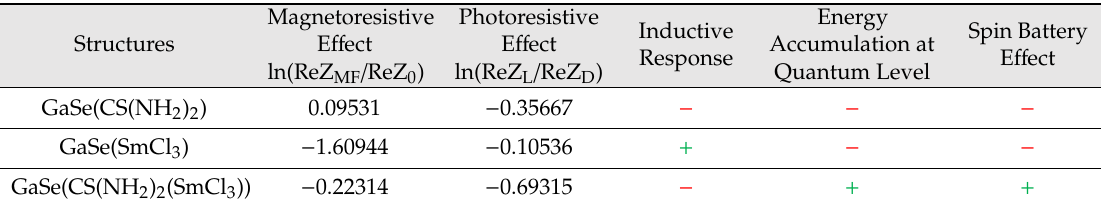
Table 1. The magnetoresistive and photoresistive characteristics of the GaSe-based hierarchical structures and the prospective fields of their applications. Magnetoresistive Photoresistive Energy Inductive Spin Battery E ff ect Accumulation at Structures E ff ect Response E ff ect ln(ReZ L / ReZ D ) Quantum Level ln(ReZ MF / ReZ 0 ) GaSe(CS(NH 2 ) 2 ) 0.09531 − 0.35667 − −